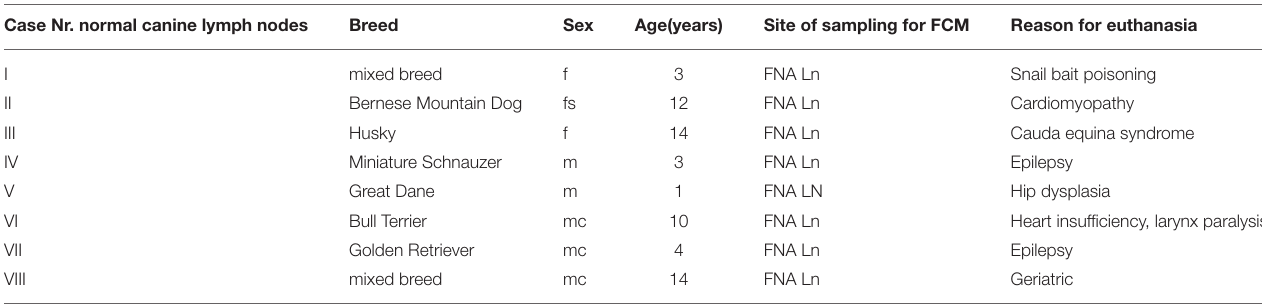
TABLE 1 | Case numbers consecutively used throughout the manuscript (#I to #VIII) with breed, sex, age in years, site of sampling for FCM listed for the 8 normal canine lymph node cases included in the manuscript. Case Nr. normal canine lymph nodes